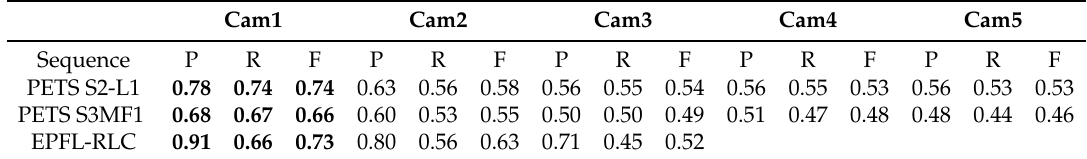
Table 2. Precision (P), Recall (R), and F-score (F) values obtained for each Camera (Cam) transferred detection with the faster R-CNN detector [13].